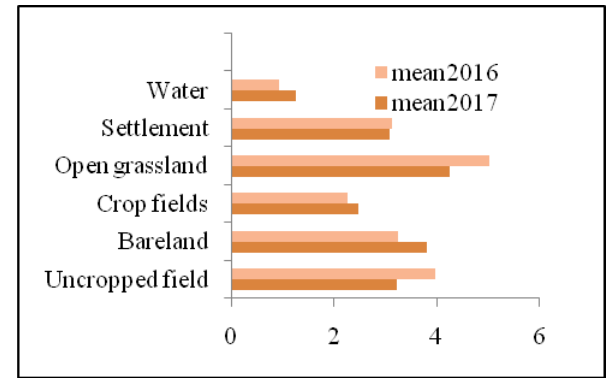
Figure 5: Mean comparison of classes for both